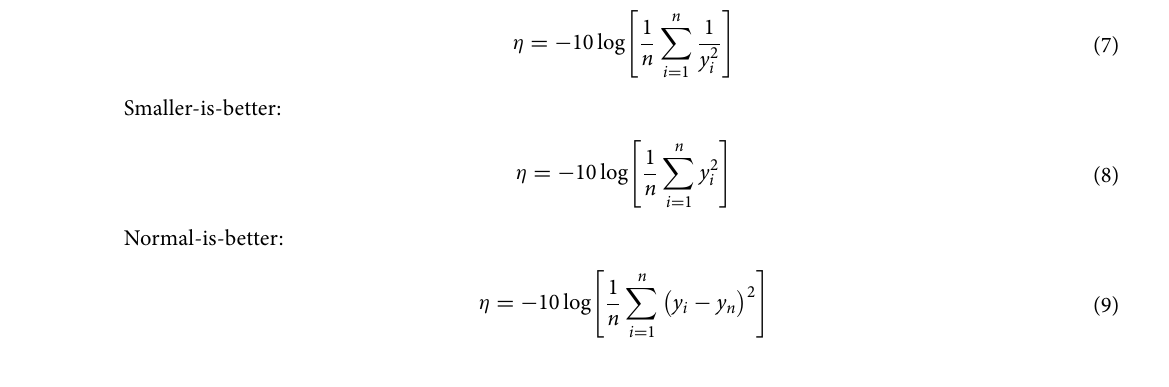
where n is the number of prosses parameters. As a result, a larger GRG implies that the process parameter com- bination is closer to the ideal. After that, all experimental experiments were ranked based on GRG values from 1 to 9, the highest GRG value representing the Optimum run, and it is considered 1st rank. So, the 8th test, which has the highest GRG value, so the 8th experiment has the best characteristics among the other trials. Analysis of GRG data. Analysis using ANOVA and S/N ratio. Signal-to-noise (S/N) ratio is used to optimize process parameters and examine each parameter’s impact on response. In the S/N ratio, the "signal" indicates the desired effect, while the "noise" indicates the undesirable effect for the responses. Therefore, if the S/N ratio is higher, it indicates the optimal conditions. According to the expected quality characteristics of different responses, there are different types of S/N ratios, including larger-is-better, smaller-is-better, and normal-is-better. Where η represents the S/N ratio, yi represents the response value of the target experiment in the orthogonal array, yn shows the variance, and n is the number of experiments Larger-is-better: